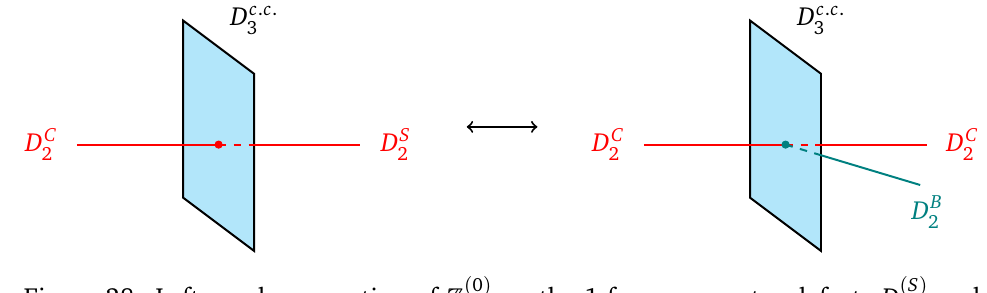
Figure 28: Left: exchange action of (cid:90) p 0 q D p C q . Right: equivalently, the 1-form symmetry defect D p B q 2 subgroup is emitted at the junction of D p´q “ A C 2-group δ B 2 1 2